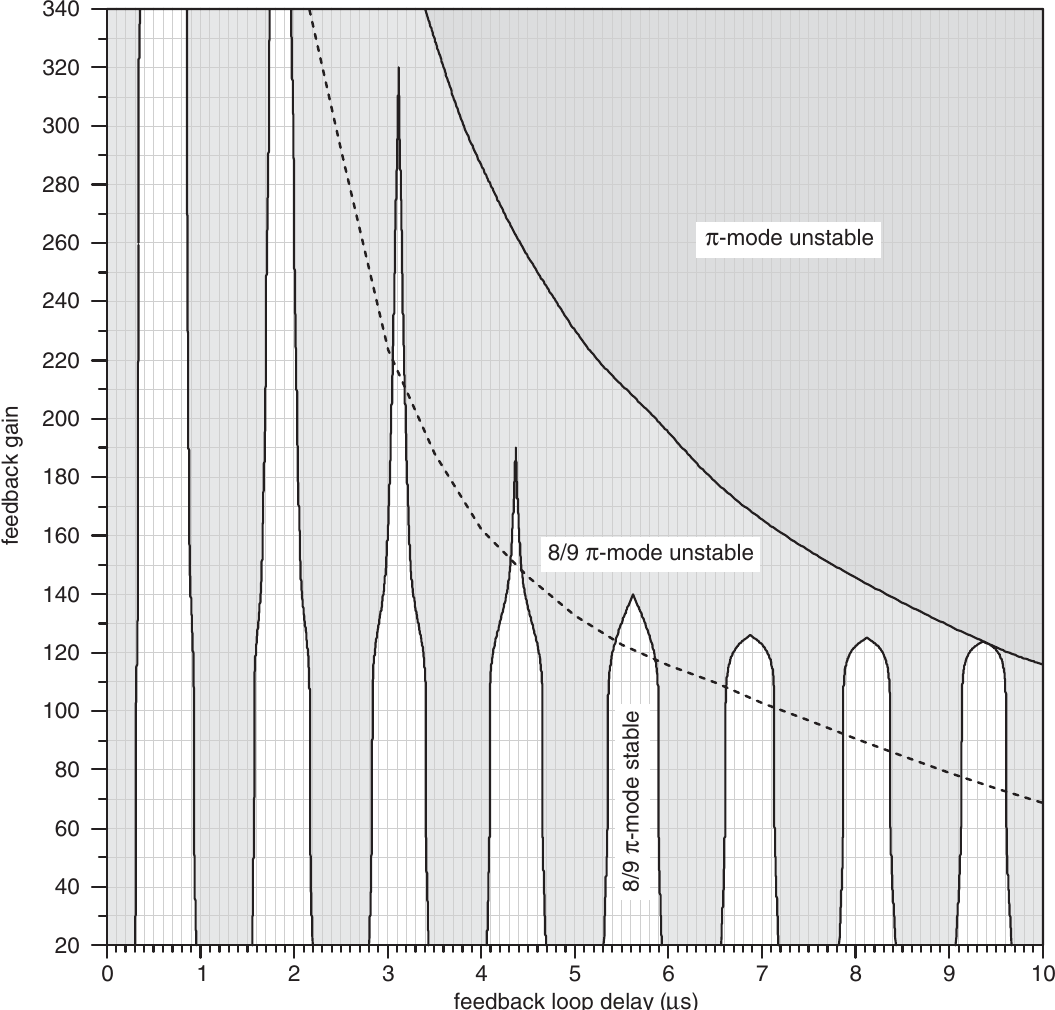
FIG. 9. Stability chart for a single cavity digital control loop operating with 1 MHz sample rate. For simplicity, 800 kHz was chosen (cid:2) -mode difference frequency and equal coupling for both modes ( (cid:3) (cid:1) for the 8 9 expanded, see text. A phase margin larger than 30 deg with respect to the (cid:2) -mode is obtained by choosing gain values below the dashed